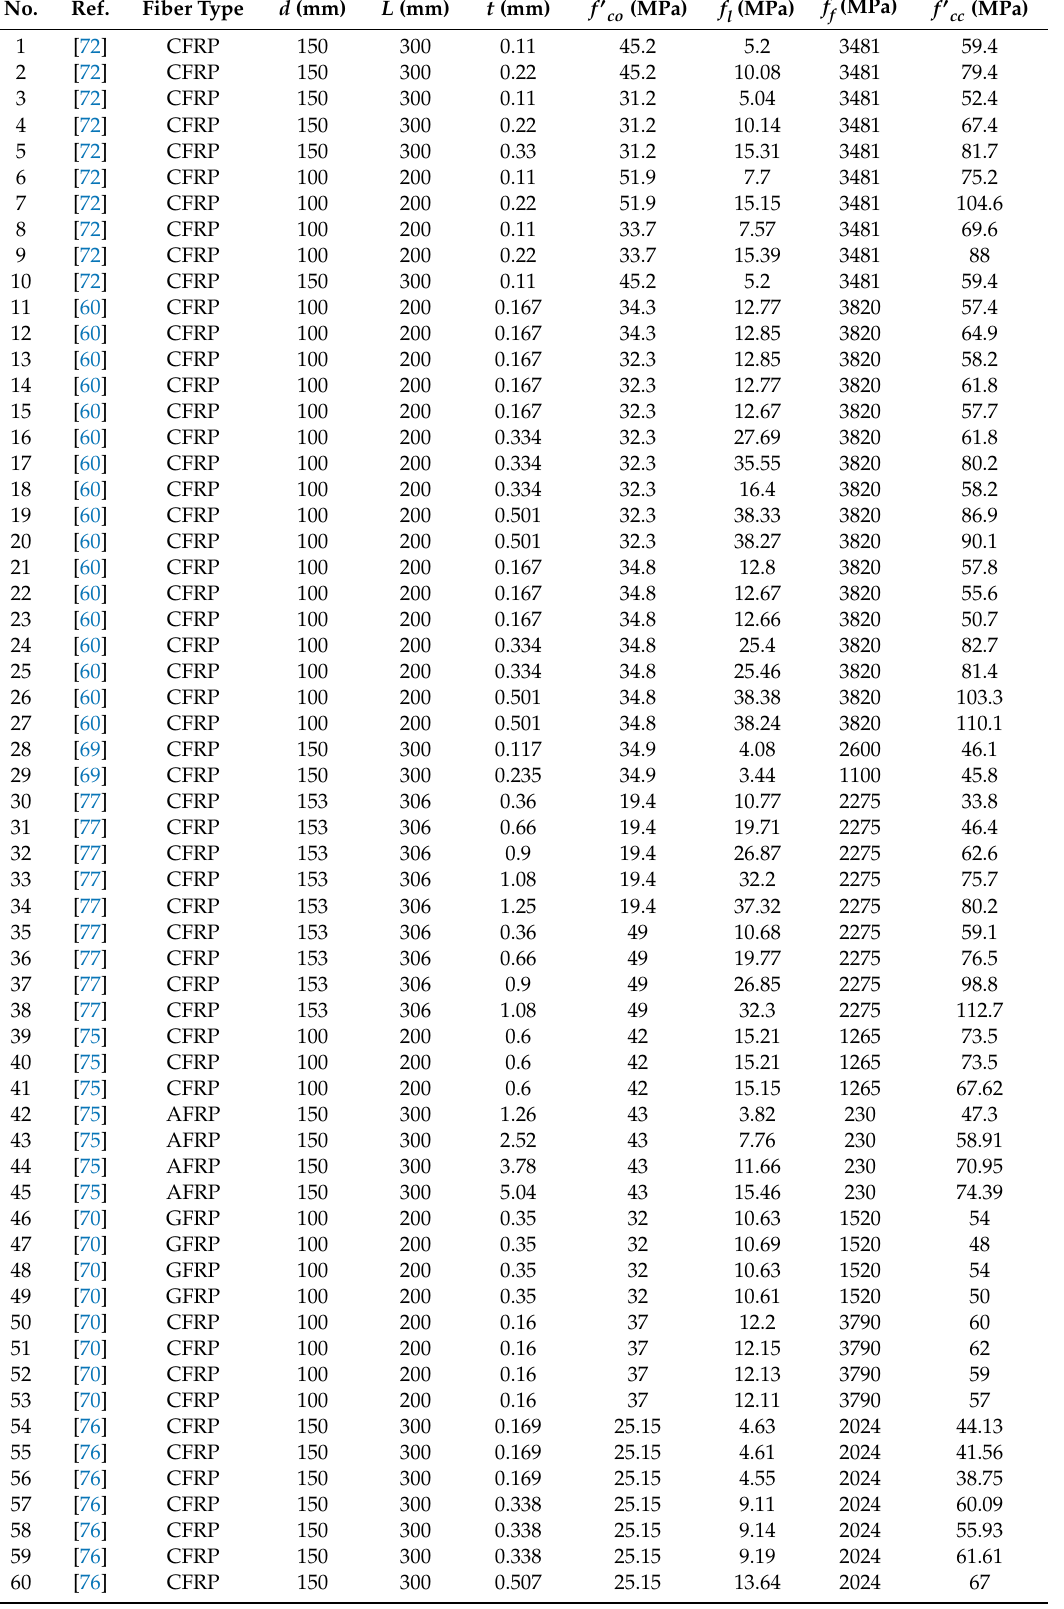
Table A1. The collected data from experimental